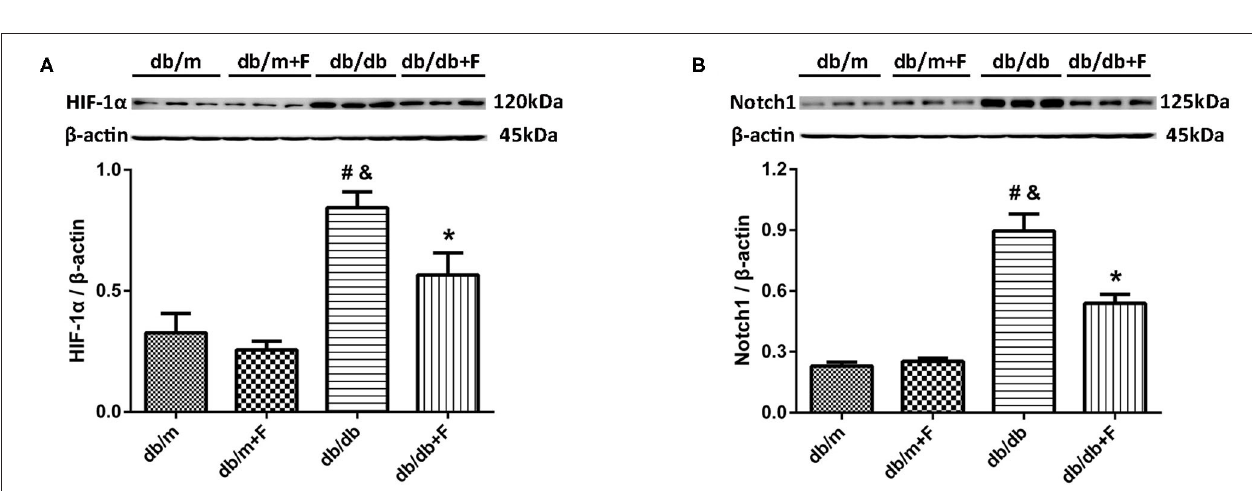
FIGURE 6 | Hypoxia-inducible factor (HIF)-1 α and Notch1 in mouse kidneys. (A,B) Representative photographs and quantification of HIF-1 α (A) and Notch1 (B) in mouse kidneys measured by western blot. n = 6 mice/group. # P < 0.05 vs. db/m group; & P < 0.05 vs. db/m + F group; * P < 0.05 vs. db/db group. Db/m, db/m mice without fenofibrate treatment; db/m + F, db/m mice with fenofibrate treatment; db/db, db/db mice without fenofibrate treatment; db/db + F, db/db mice with fenofibrate treatment. Data are means ±